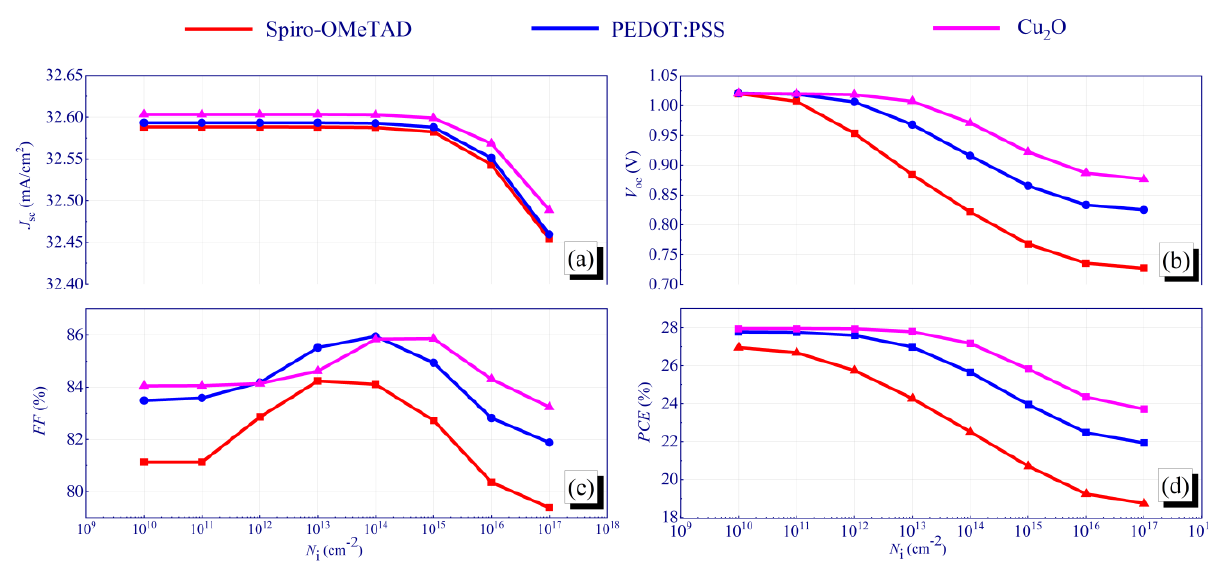
Figure 5. Influence of the concentration of interfacial defects ( N i ) at the TiO 2 /CH 3 NH 3 SnI 3 (IL1) interface: ( a ) J SC , ( b ) V OC , ( c ) FF , ( d ) PCE .